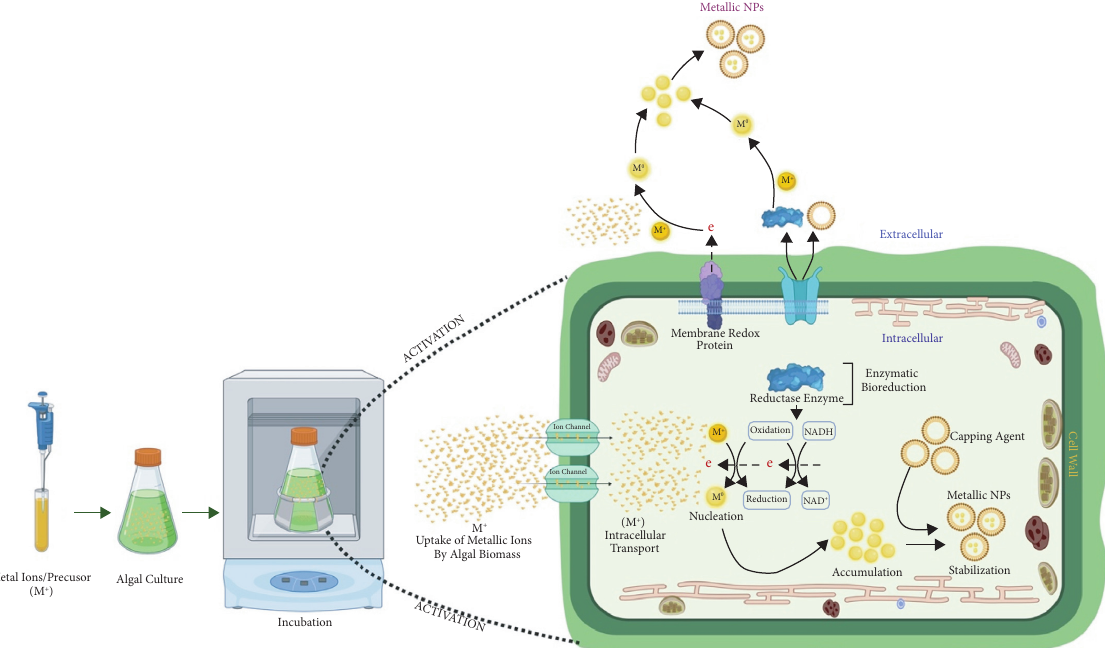
Figure 5: Schematic diagram showing mechanism of intracellular NPs synthesis in algae. Metallic ions get inside the cytoplasm, thereby getting reduced by nitrate reductase enzymes produced from different biochemical reactions. Several biogenic molecules act as capping agents to stabilize finally producing biogenic metallic NPs. However, the extracellular mechanism involves the trapping of metal ions near the cell wall or ECMs, which contain several reducing agents, as well as there is secretion of reducing enzymes and metabolites to the external environment. Altogether, they assist the reduction of metal ions to finally produce capped and stabilized metallic NPs. Created with BioRender.com with publication